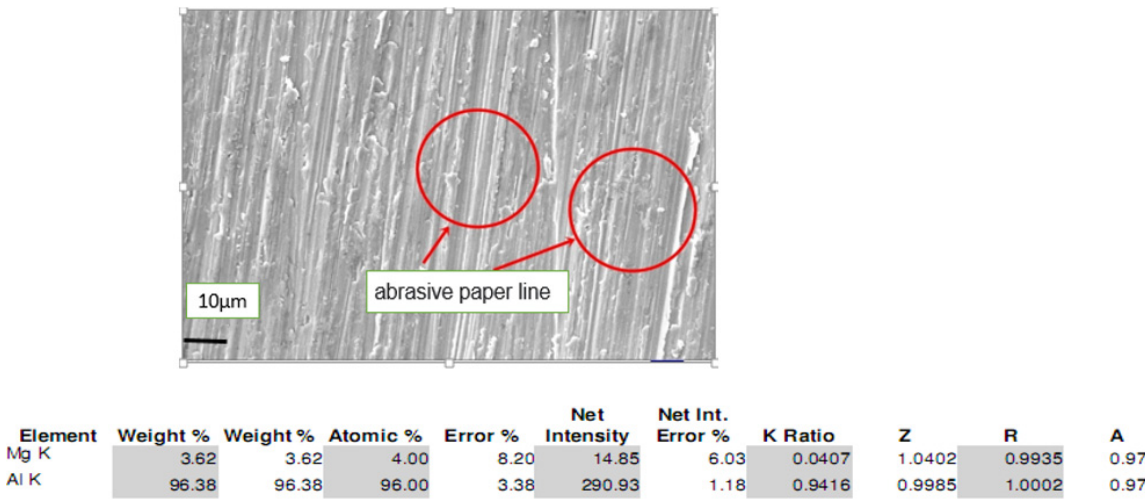
Figure 4. Photo of surface morphology and elemental analysis of metal composition of AA5052 us ‐ ing SEM ‐ EDX.